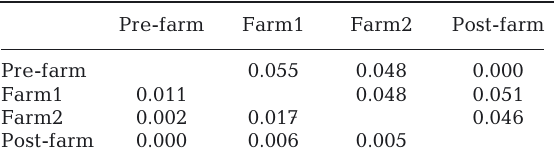
Table 7. DNA marker characteristics for all 10 loci. N = number of genotyped Atlantic cod individuals, H obs : observed hetero - zygosity,